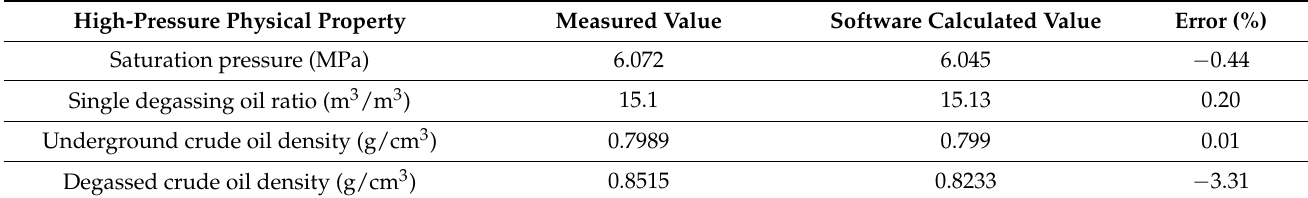
Table 2. Matching comparison of main properties of formation crude oil